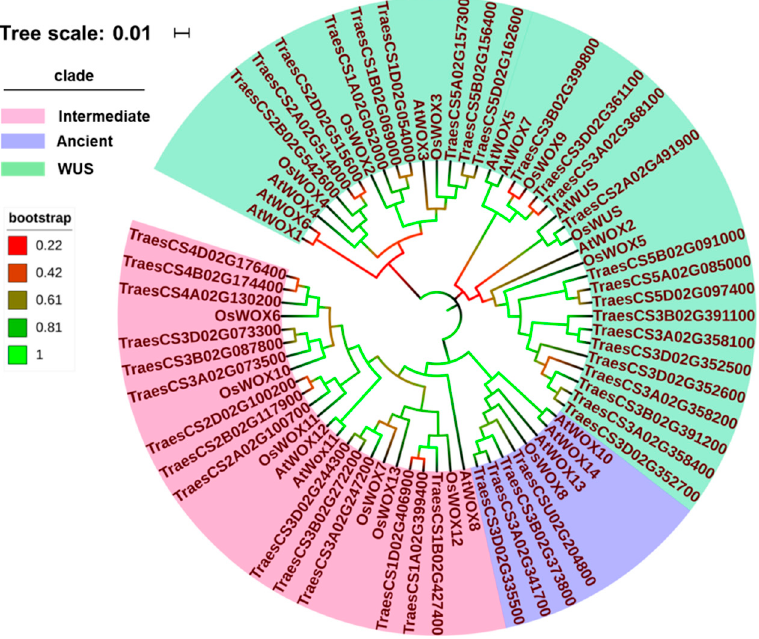
Figure 4. Phylogenetic relationships among WOX proteins in T. aestivum , rice and Arabidopsis. Phylogenetic tree was constructed based on the sequences of WOX proteins in T. aestivum , rice and Arabidopsis, performed by the MEGA X using neighbor-joining approach with 1000 bootstrap replicates. WUS clade harbors WUS, WOX2 to WOX5, WOX9 in T. aestivum and rice, TaWOX13, TaWOX14, AtWUS and AtWOX1 to AtWOX7; intermediate clade contains WOX6, WOX7, and WOX10 to WOX12 in T. aestivum and rice, AtWOX8, 9, 11, and 12; and ancient clade contains WOX8 in T. aestivum and rice, AtWOX10, 13, and 14. Scale plate and legend in upper left displayed tree scale and bootstrap value.